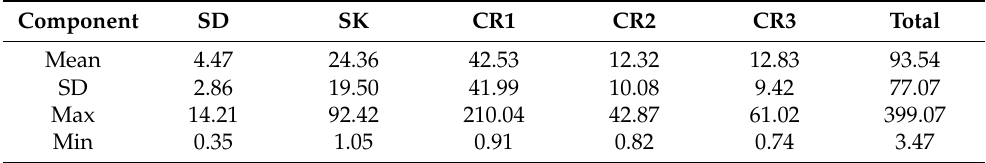
Table 5. Stump and coarse root biomass components (kg).